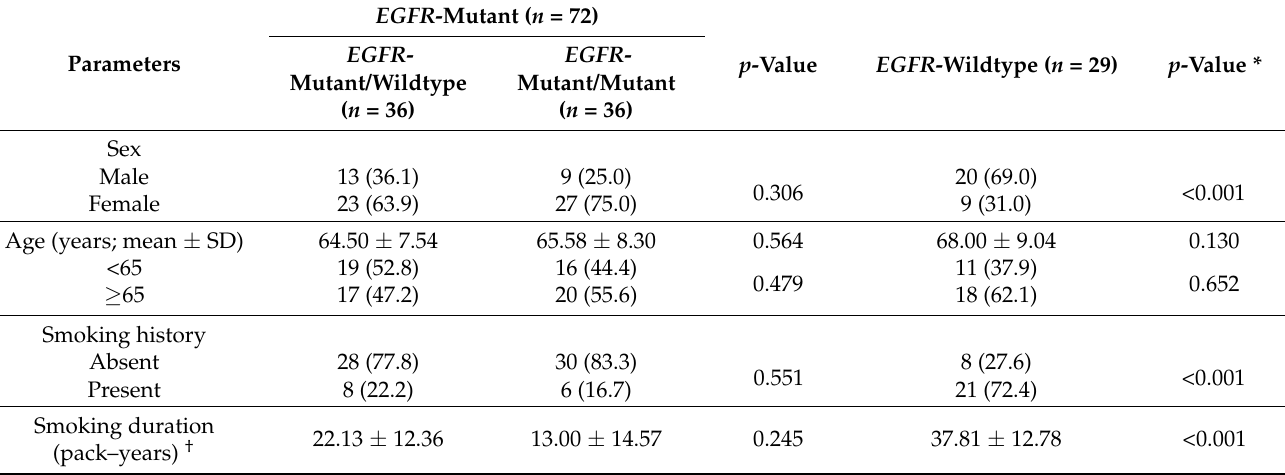
Table 2. Comparison of demographic parameters between patients with EGFR -wildtype tumors and EGFR -mutant